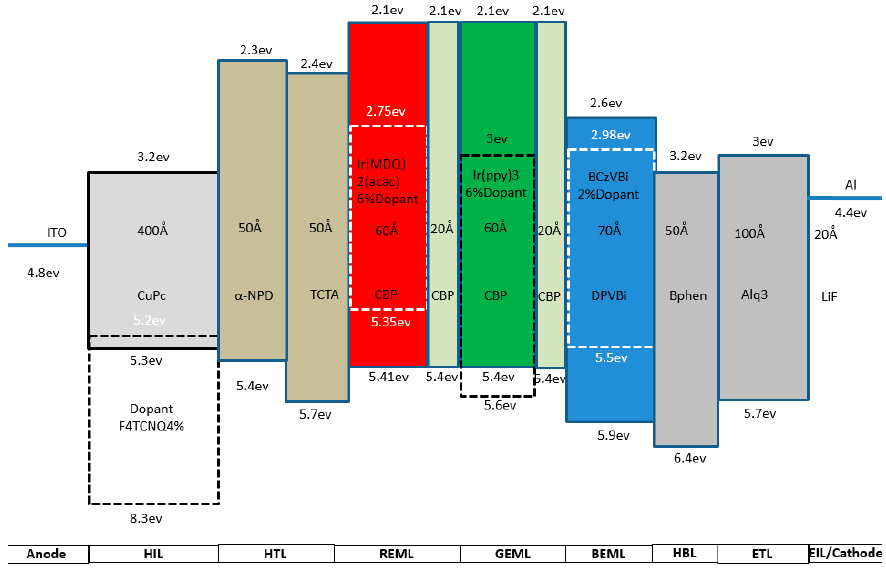
Figure 1. Red–green–blue (RGB)-stacked white organic light emitting diode (WOLED) device structure.